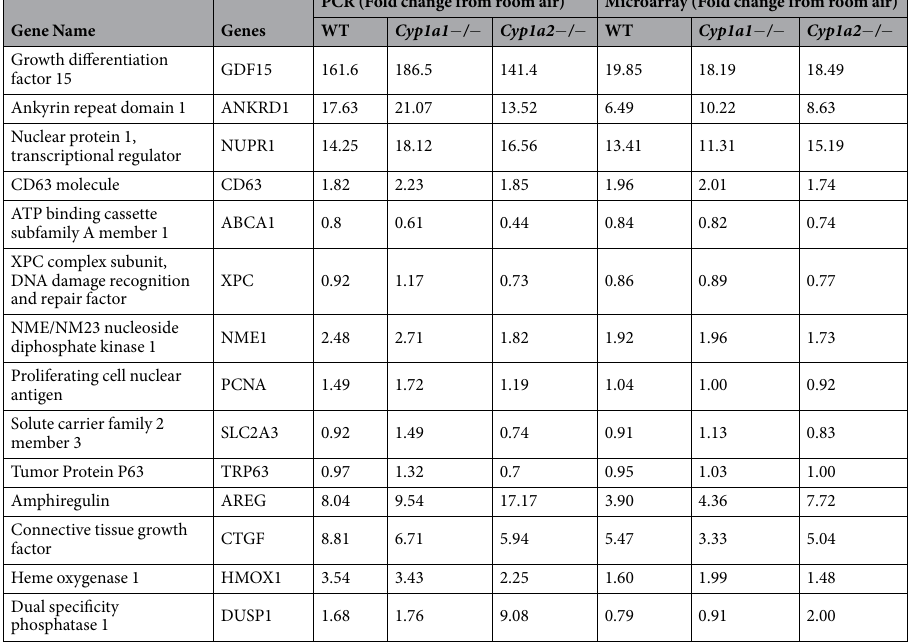
Table 3. Table showing Fold change in gene expression for selected genes with Real time PCR and Microarray.